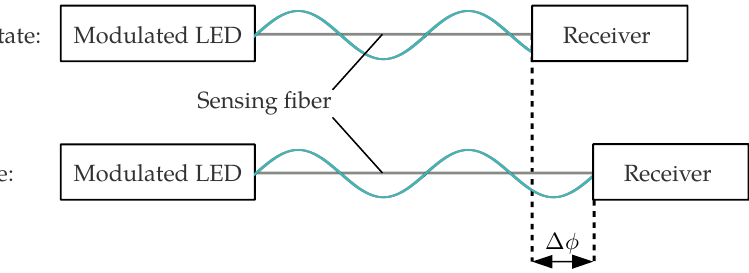
Figure 3. Change of the modulation phase due to